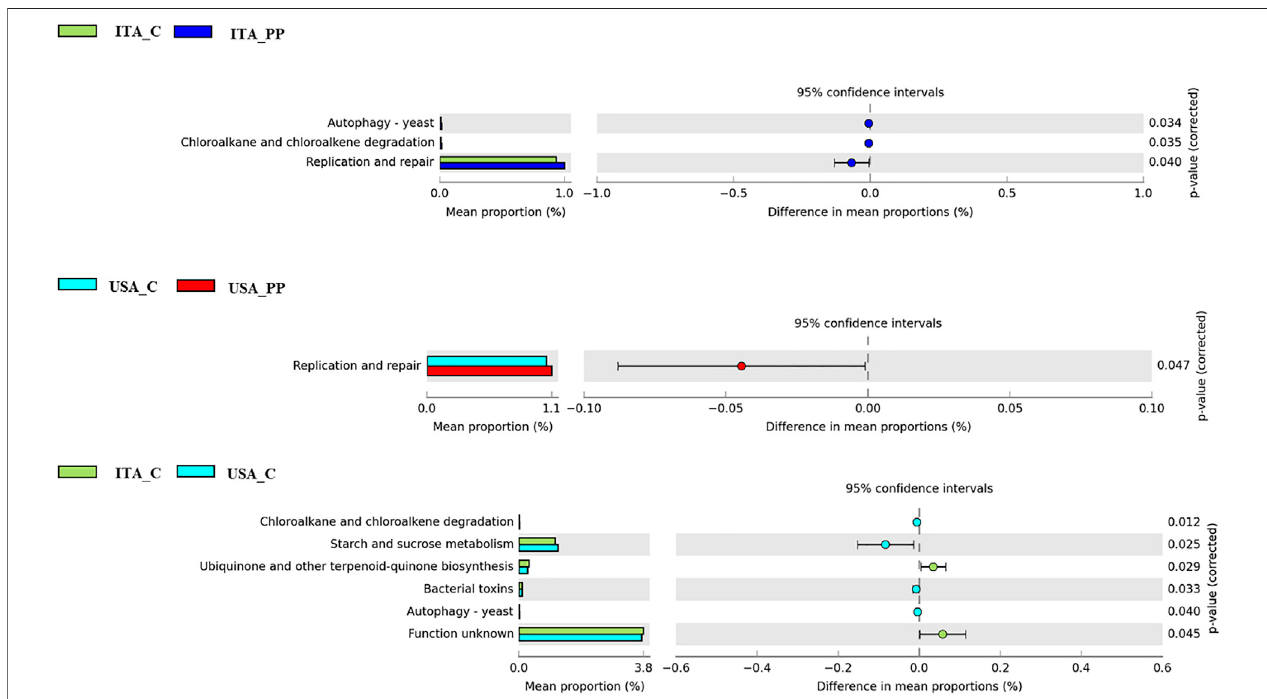
FIGURE 4 | Extended error bar plots showing PICRUSt-predicted bacterial KEGG pathways statistically different between experimental groups.